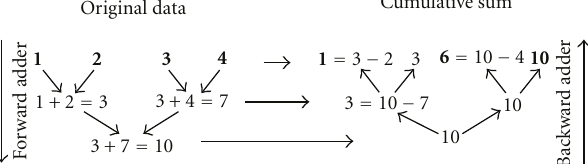
Figure 4: A parallel implementation of cumulative sum generation of the numbers 1,2,3, and 4. First the sum, 10, is calculated using a forward adder tree. Then the partial summation results are used by the backward adder to construct the cumulative sum; 1,3,6, and